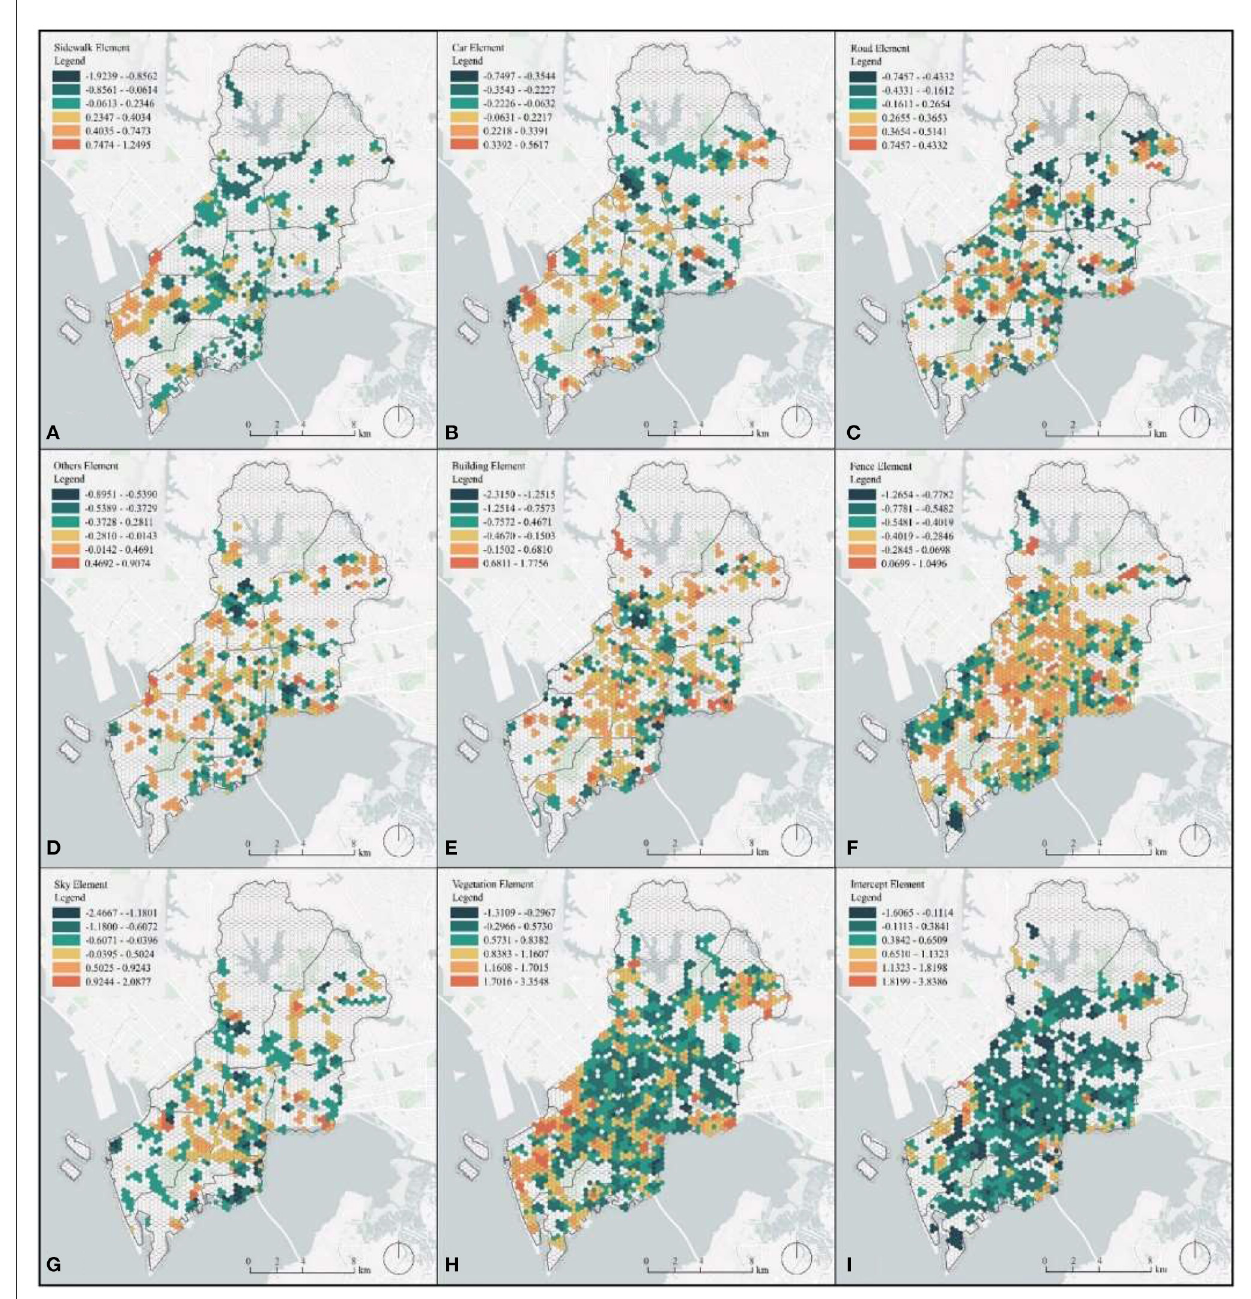
regression coefficients were produced by retaining the data with significant ( p < 0.05) data for each visual element, as shown in Figure 7. Violin plots can be used to show the distribution and density of the data by combining the advantages of box line and kernel density plots (31). The curved line in the violin plot is a symmetric display of the kernel density distribution, the middle part shows the 2.5, 25, 50, 75, and 97.5% quartiles, and the straight line in the middle of the violin plot connects the minimum and maximum